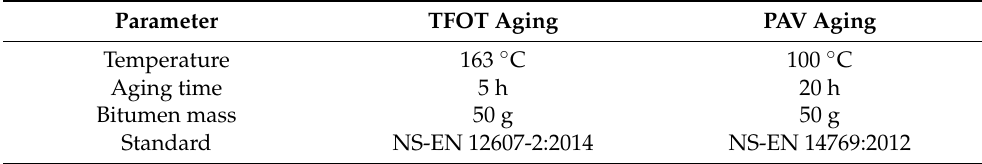
Table 2. Parameters of thermal-oxidative aging.